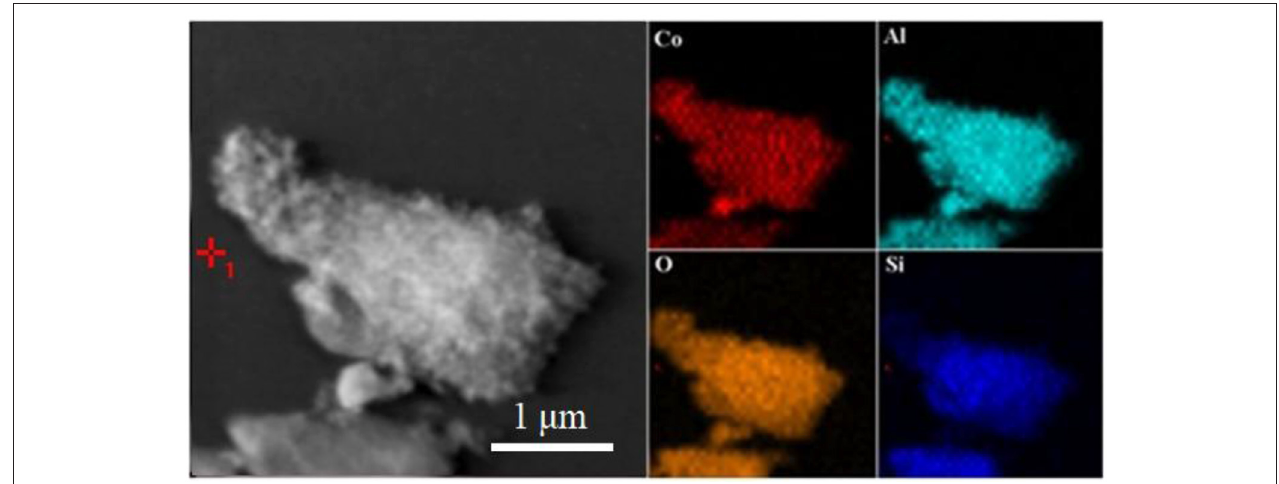
FIGURE 3 | TEM image and the corresponding element mapping of CoAl 2 O 4 /Kaol-1100 ◦ C.